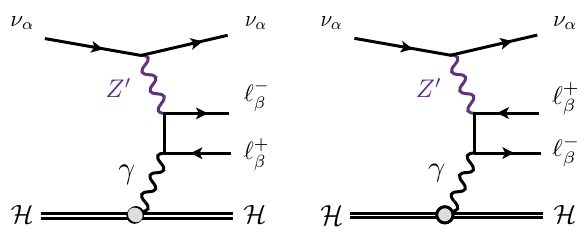
Figure 18.1: New physics contribution to neutrino trident production.